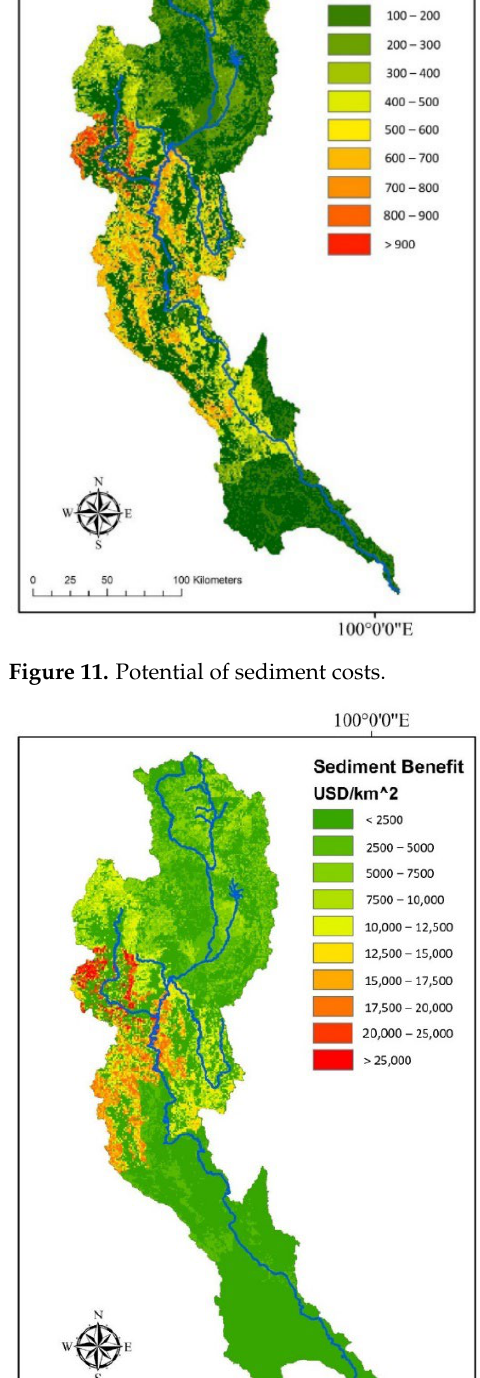
Figure 12. Potential of sediment Figure 11. Potential of sediment costs.